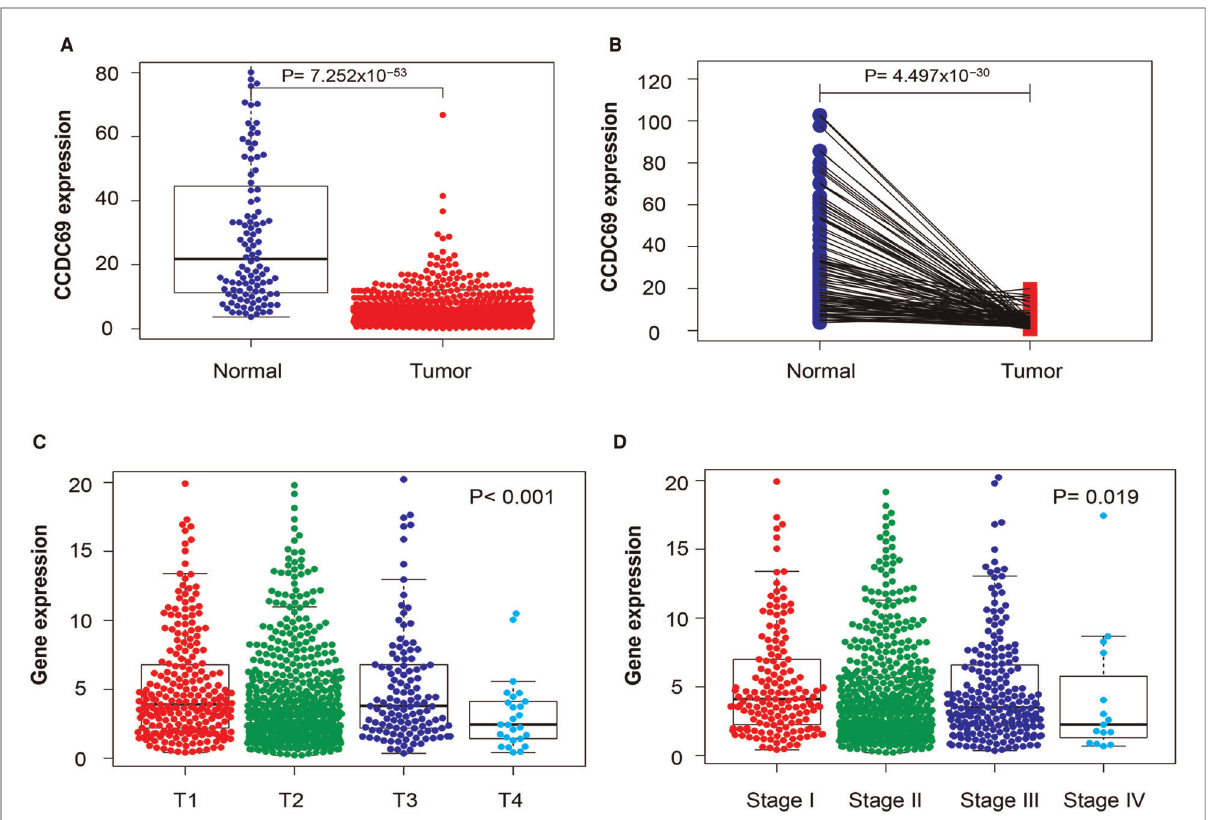
FIGURE 2 The expression level of CCDC69 was correlated with the BC clinical characteristics. ( A ) The expression level of CCDC69 in normal and BC specimens. ( B ) CCDC69 expression level of BC and paracancer tissue samples. The expression level of CCDC69 was correlated with tumor size ( C ) and pathological stage ( D